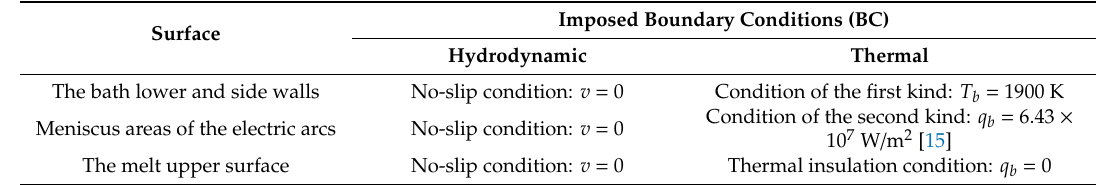
Table 2. Boundary conditions.